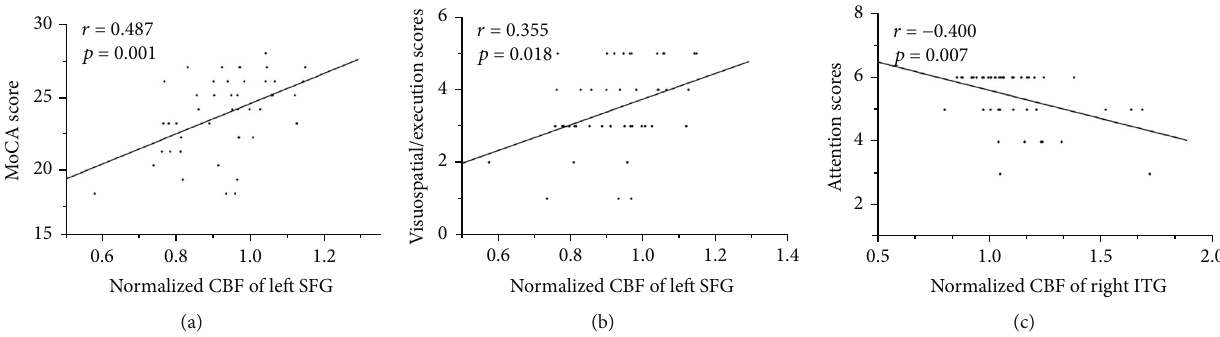
Figure 5: The signi fi cant correlations between the CBF changes and the neurocognitive outcome. The MoCA scores (a) and the visuospatial/execution scores (b) were positively correlated with the normalized CBF of the left SFG, respectively ( r = 0 : 487 , p = 0 : 001 ; r = 0 : 355 , p = 0 : 018 ). The attention scores (c) were negatively correlated with the normalized CBF of the right ITG in the acute mTBI patients ( r = − 0 : 400 , p = 0 : 007